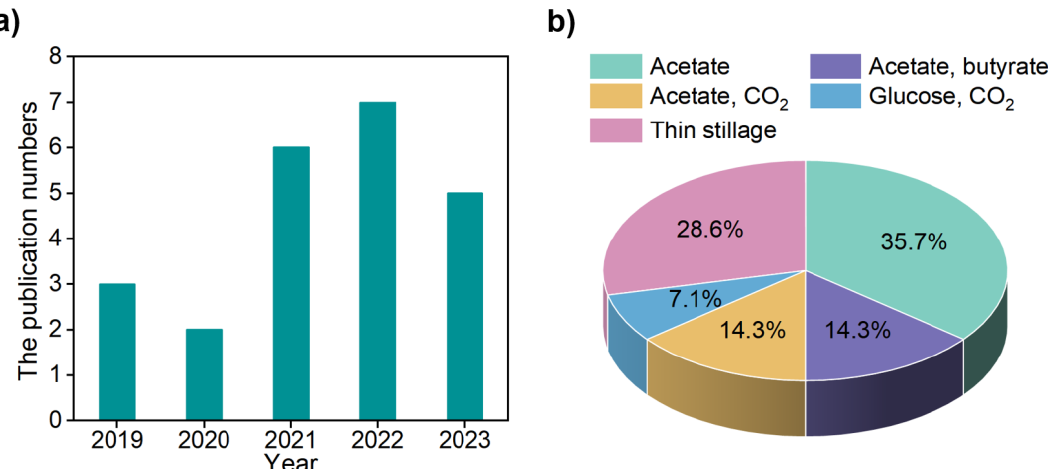
Figure 3. ( a ) The number of publications in the last five years related to MCCAs electrofermentation; ( b ) the raw materials used in MCCAs electrofermentation system.